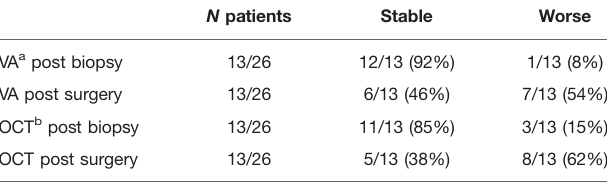
TABLE 3 | VA and OCT variations after surgical procedure.